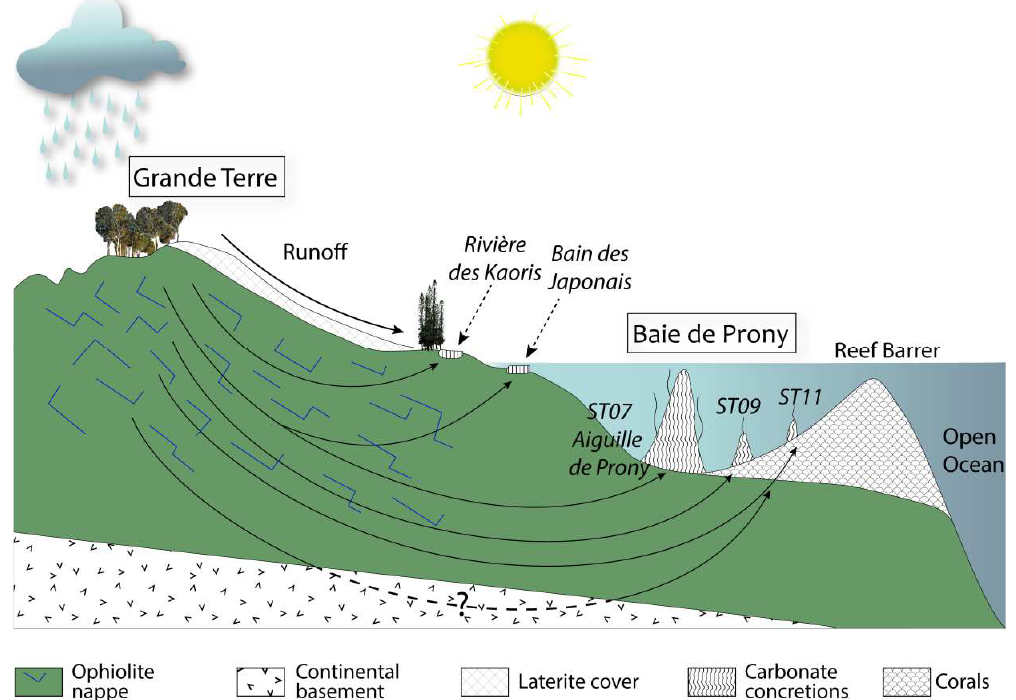
Figure 11. A sketch of the general geological setting of the Prony hydrothermal field (PHF, not to scale). The ophiolite nappe is covered by a thick lateritic cover. The hydrothermal system is fed by meteoric waters that percolate through the densely fractured peridotites and discharge at springs in the lagoon where the high-pH waters mix with seawater. Note the position of the spring of the Rivière des Kaoris above sea level, while the Bain des Japonais is uncovered at low tide and the other springs always under water. The arrows tentatively indicate the pathways of the fluid percolation and point to the question of the nature of the geological formations leached by the waters: ophiolite nappe, continental basement and/or coral